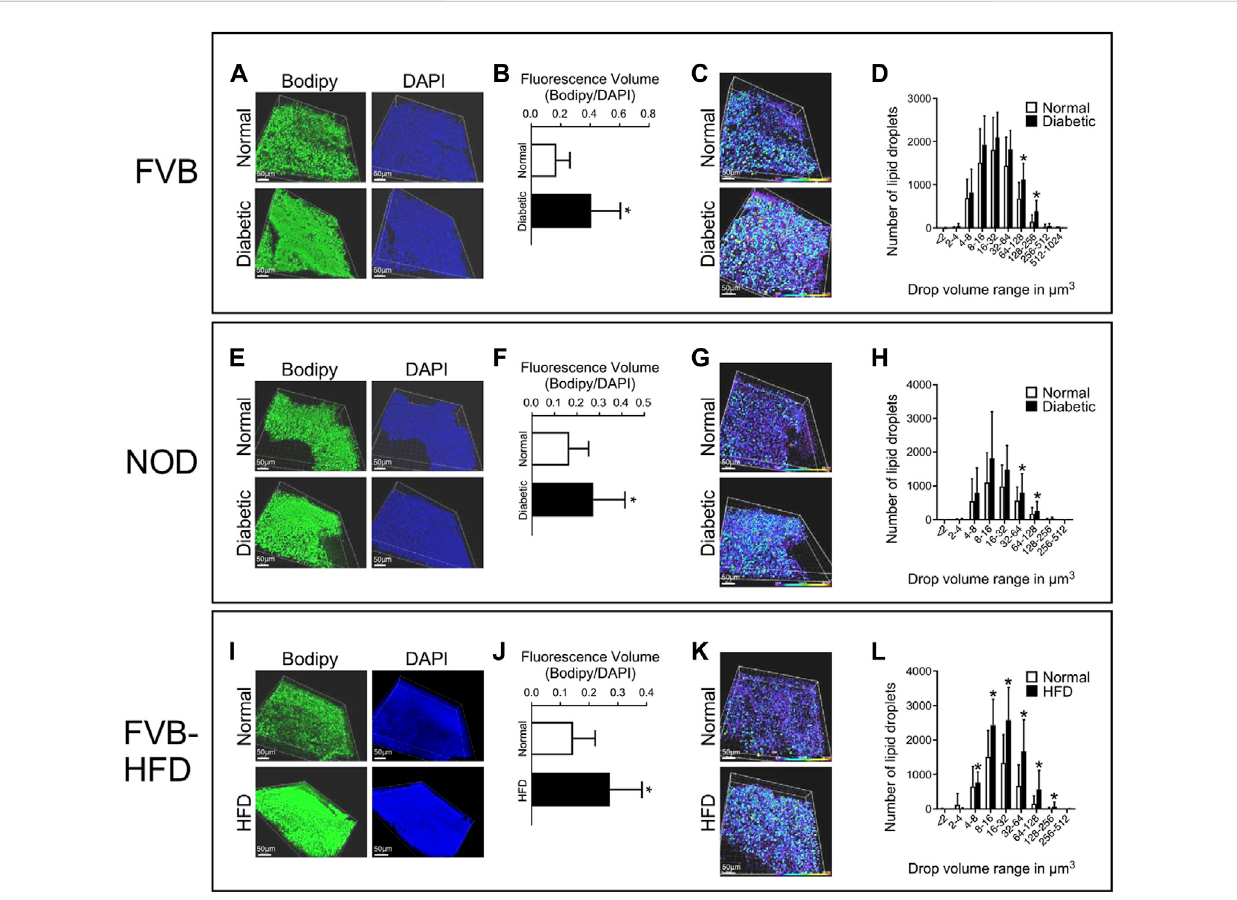
FIGURE 3 Excess lipid accumulation in yolk sacs from diabetic and obese pregnancies. Confocal imaging was performed on E8.5 yolk sacs stained with Bodipy(lipids)andDAPI(DNA)forallthreeexperimentalmodels.Panels A , E ,and I :Three-dimensionalrenderingsofsignalsforlipidsandDNA.Panels B , F , and J :Voxelsdetectedineachchannelwerequanti fi ed,andtheratiooflipidoverDAPIvoxelswascalculated.Thisratiowassigni fi cantlyhigherinvisceral yolk sac from diabetic FVB and NOD pregnancies, and in pregnancies where the dam was fed high-fat diet. Panels C , G and K : Volumes of lipid droplets were pseudo-colored for imaging according to size, following the scale at the right bottom of each image, purple-blue = smaller, yellow-red = larger volume. Yolk sacs from diabetic pregnancies and from dams fed HFD display appreciably more droplets with colors representing larger volume ranges. Panels D , H and L : Quanti fi cation of the numbers of lipid droplets within a given size range; note that the scale of the X -axis is logarithmic (log2), andthat X and Y axisscalesdifferwhencomparing D to H and L .Frequenciesofoccurrenceareshiftedtowardslipiddropletsoflargervolumesinyolksacs from diabetic FVB and NOD dams, and HFD pregnancies. Sample size: FVB Normal = 25 samples representing 14 yolk sacs from 4 pregnancies, FVB diabetic = 43 samples representing 21 yolk sacs from 7 pregnancies; NOD Normal = 26 samples representing 14 yolk sacs from 5 pregnancies, NOD diabetic=36samplesrepresenting 25yolksacsfrom9pregnancies;FVBNormal=42samplesrepresenting14yolksacsfrom4pregnancies, FVB-HFD= 68 samples representing 24 yolk sacs from 7 pregnancies. Data were averaged for each yolk sac (where multiple fragments were analyzed), and then averaged over all yolk sacs from a given pregnancy, after which averages were calculated for all pregnancies in the respective experimental group; Averages are presented as mean ± SD. Asterisks indicate p < 0.05, when comparing experimental and control groups using two-tailed